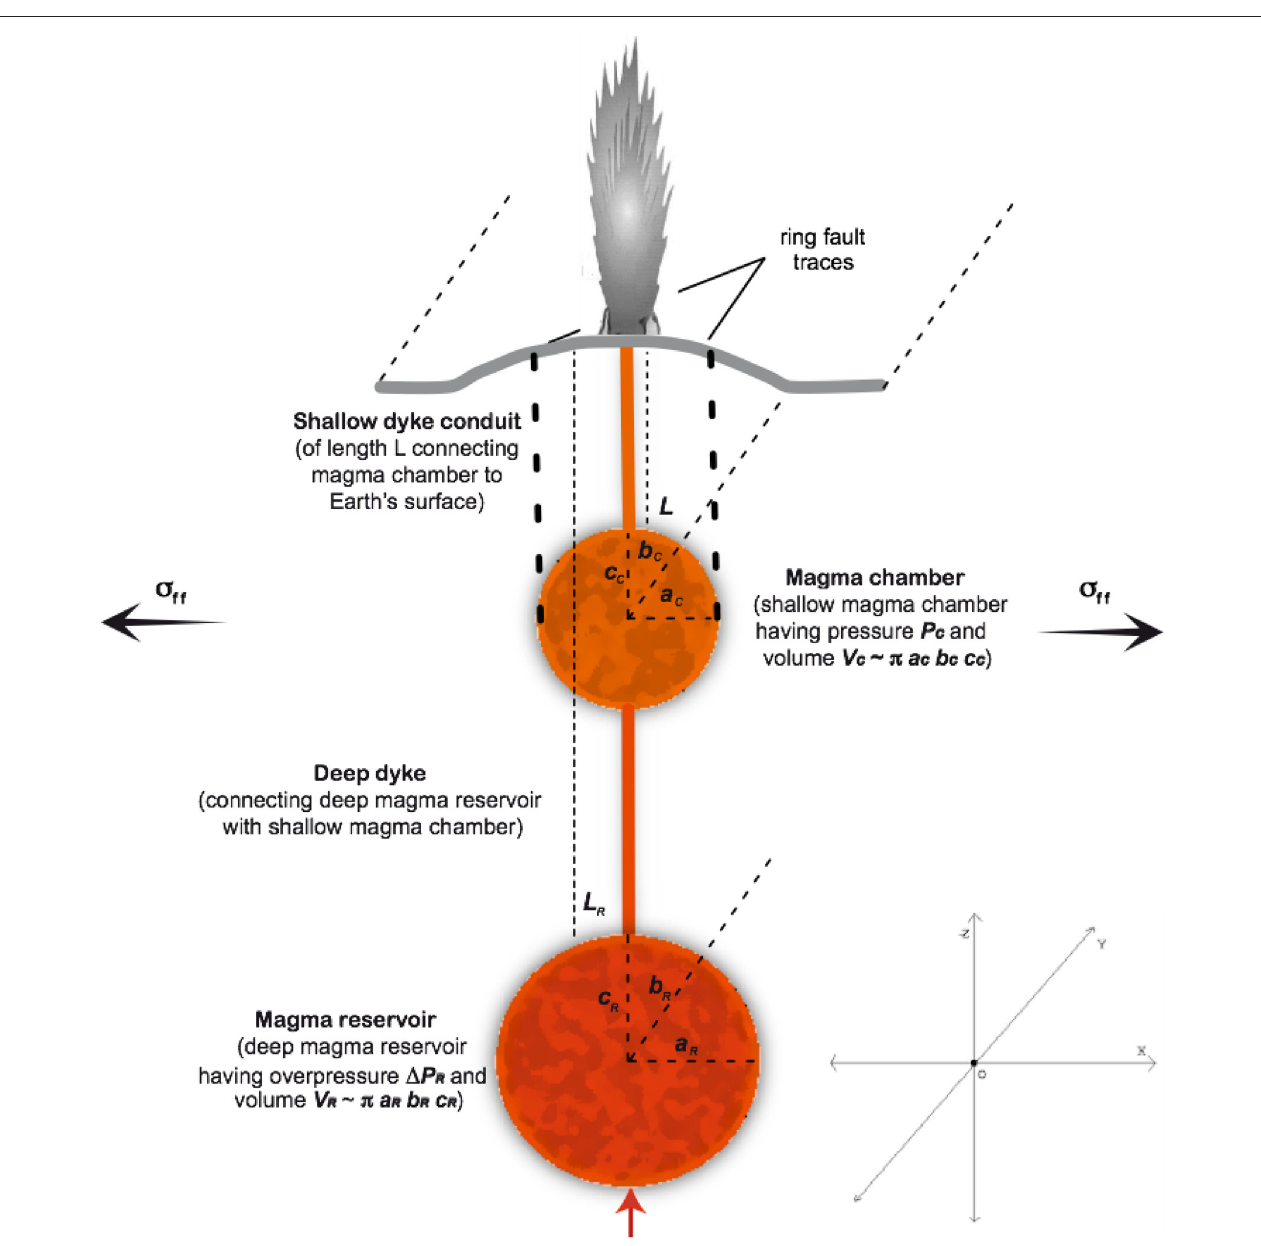
FIGURE 1 | Schematic view of the investigated system. The magma chamber having a roof placed at a depth L , is assumed to be an ellipsoid with semi-axes a C , b C , and c C with b C ≫ a C , c C (Costa et al., 2011). The magma reservoir having a roof placed at a depth L R , is also assumed to be an ellipsoid with semi-axes a R , b R , and c R with b R ≫ a R , c R . The cross-section of the shallow dyke conduit is assumed to be elliptical with a finite length 2 a d (along the y -direction) and width 2 b d (along the x